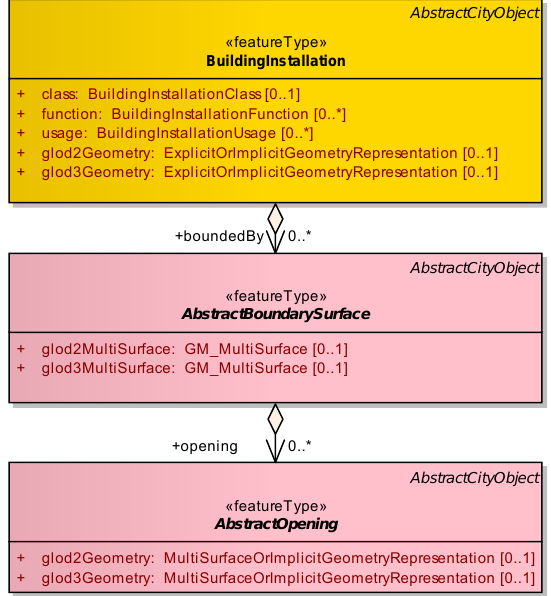
Figure 10: BuildingInstallation and related feature classes